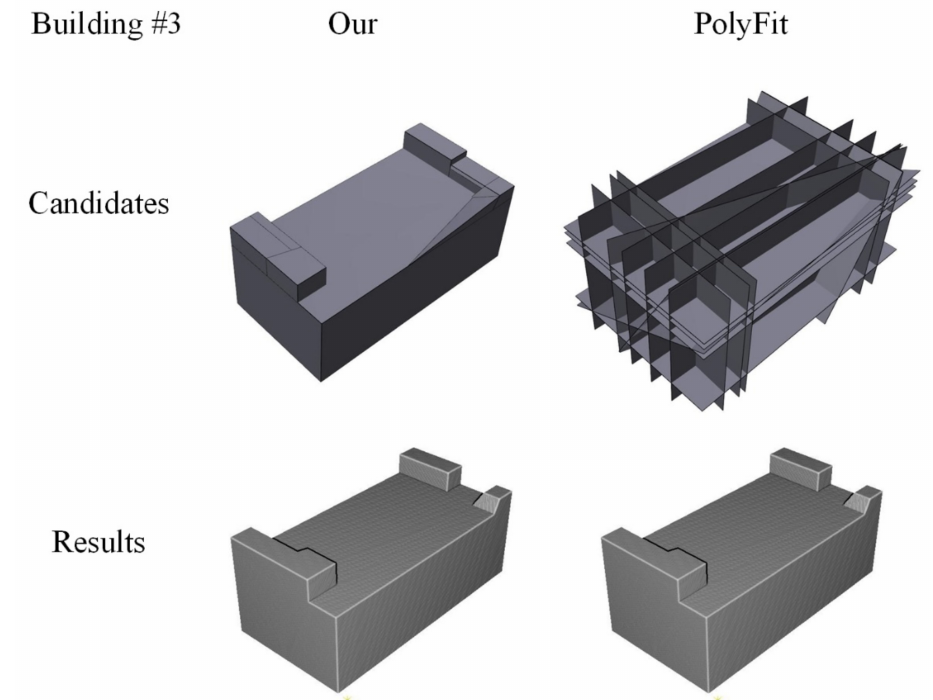
Figure 9. Comparison of candidate faces and resulting models generated by the proposed method and PolyFit [10] for Building #3.